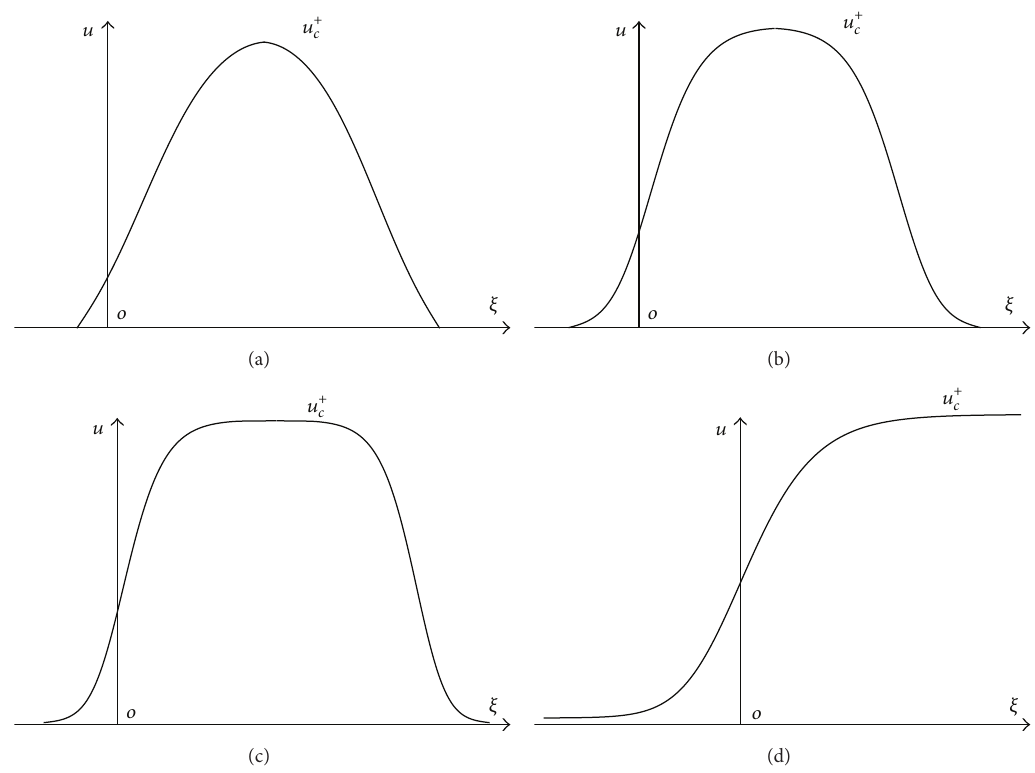
Figure 16: (The kink wave is bifurcated from the compacton-like wave). The varying process for the graph of 𝑢 + 𝑐 when 𝑐 > 0 , 𝛿 > 0 , 𝑎 > 0 , and 𝑏 → −16𝑎 2 /75𝑐 + 0 , where 𝑐 = 1 , 𝛿 = 1 , 𝑎 = 1/2 , and (a) 𝑏 = −16𝑎 2 /75𝑐 + 10 −3 . (b) 𝑏 = −16𝑎 2 /75𝑐 + 10 −4 . (c) 𝑏 = −16𝑎 2 /75𝑐 + 10 −6 . (d) 𝑏 = −16𝑎 2 /75𝑐 + 10 −8